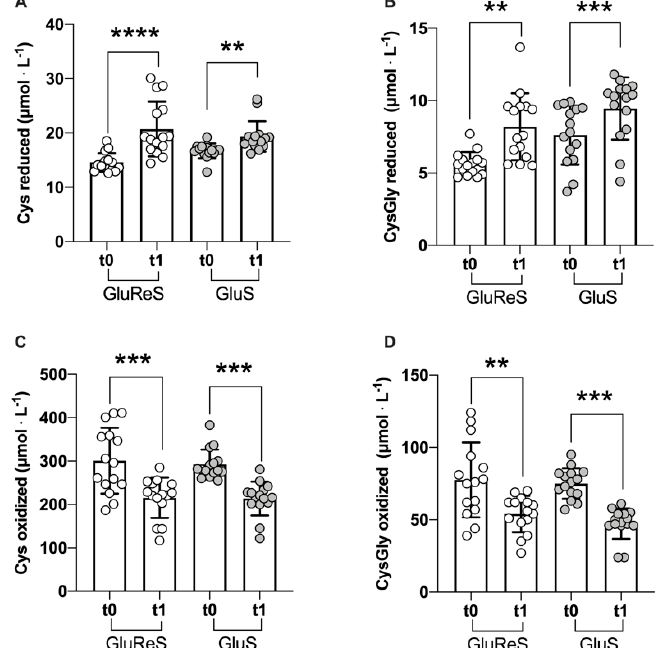
Figure 3. Scatter dot plot of reduced and oxidized thiol species measured in plasma before (t0) and after 8 weeks (t1) of dietary supplementation with GluReS or GluS. ( A ) reduced cysteine (Cys), ( B ) reduced cysteinylglycine (CysGly), ( C ) oxidized cysteine (Cys), ( D ) oxidized cysteinylglycine (CysGly). Data are expressed as the mean ± SD. Changes over time (t1 vs. t0) were significant at: ** p < 0.01; *** p < 0.001; **** p < 0.0001.